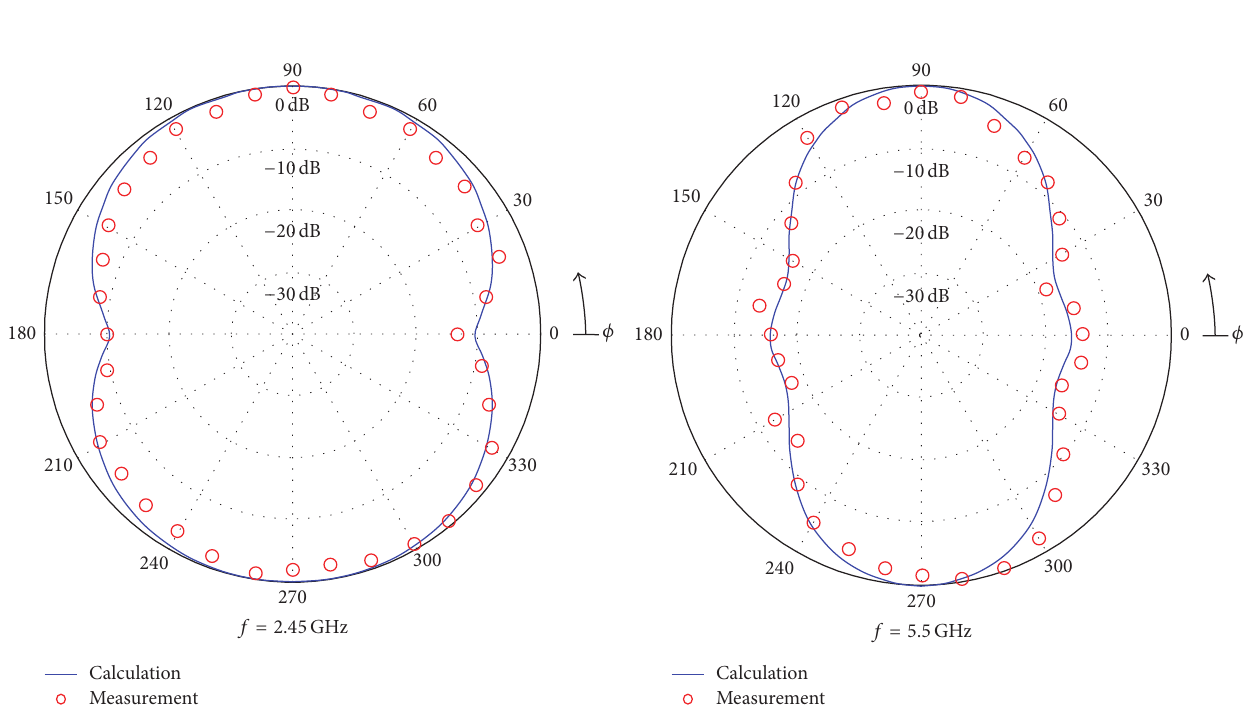
Figure 15: Radiation patterns in 𝑦 - 𝑧 plane (E-plane).